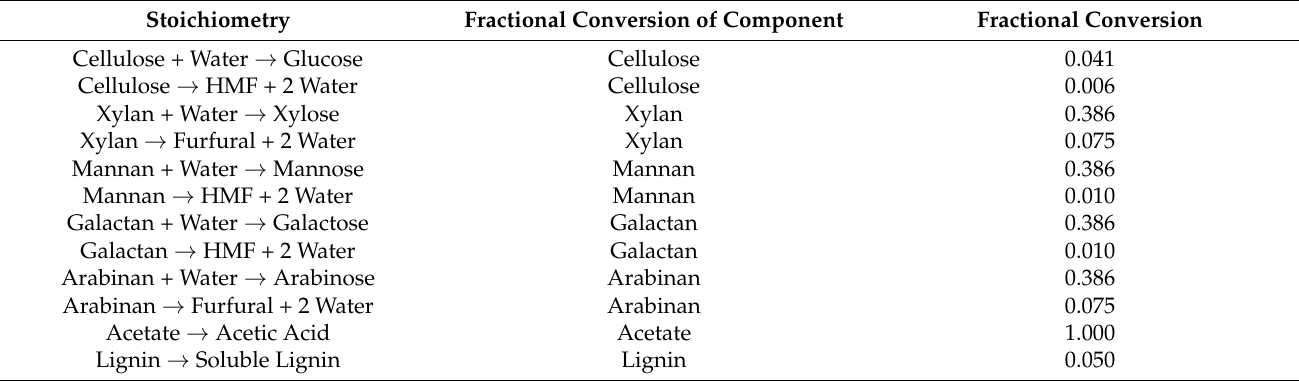
Table 2. Conversion for reaction considered in the steam explosion pre-treatment (R1).